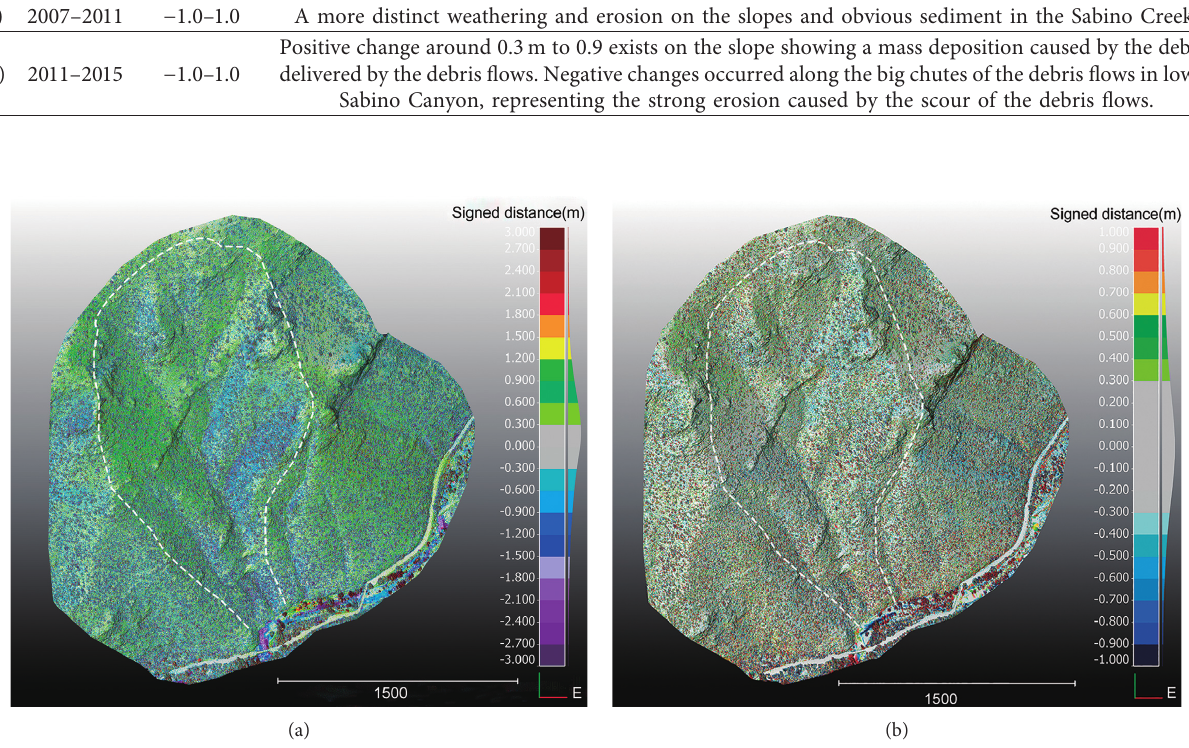
Figure 7: The change detection of debris-flow area. (a) The changes in the detection in 1# debris flow from 2007 to 2011. It showed strong erosion in debris-flow chute which ranged from 1.2m to 1.5m. A relatively small positive change ranging from 0.3 m to 0.6m occurred outside the debris flow, representing the deposition on the slope due to the weathering and small pieces of rocks that fell down from the steep initiation points. (b) The changes in the detection in 1# debris flow from 2011 to 2015. It showed inconspicuous change during these 4 years which shows that the debris flow tends to be stable.